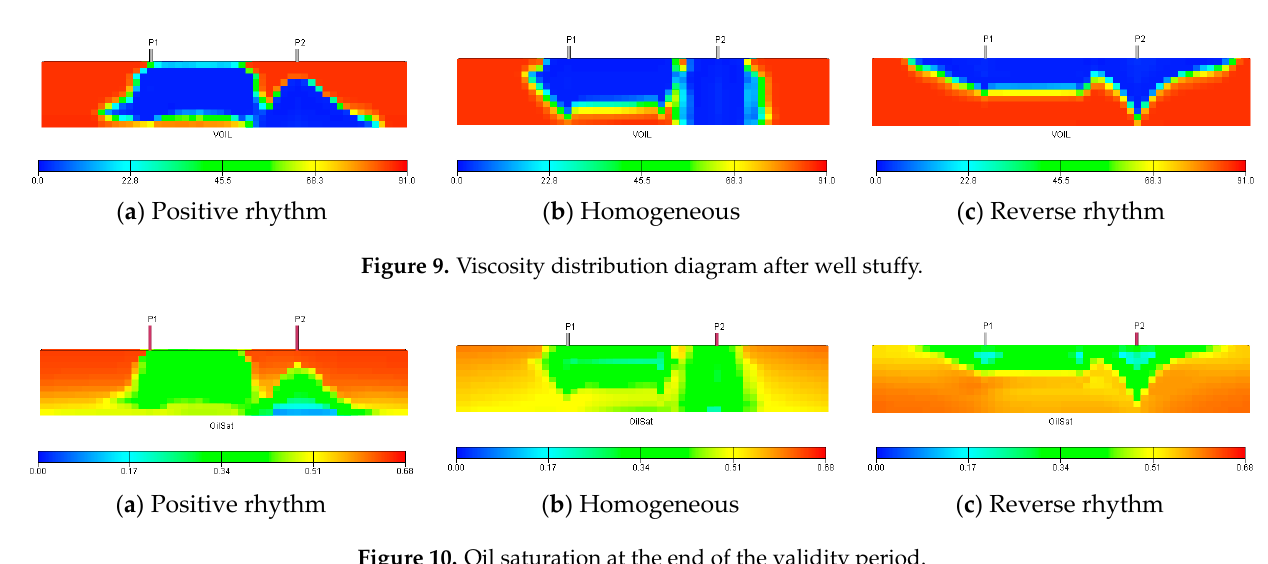
Figure 10. Oil saturation at the end of the validity period.